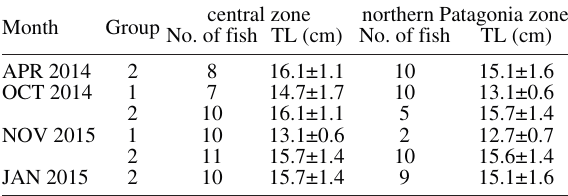
Table 1. – Month of collection, age group (1, adults 1 year; 2, adults >2 years), catch zone, mean (±S.D.), total length (TL) and number of Engraulis ringens individuals used for otolith microchemical